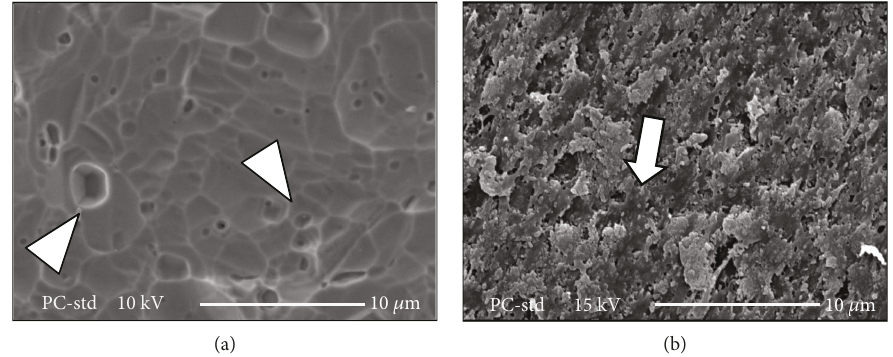
Figure 1: Morphological characteristics of the surface of TI (a) and HA-PLLA (b). SEM images show the surface di ff erences between two materials. The surface of Ti appeared relatively smooth, and micropores (arrowheads) were found in some places on Ti. The surface of HA-PLLA appeared relatively rough, and interspersed white particulates, which seemed to be HA crystals (arrow), were visible in some